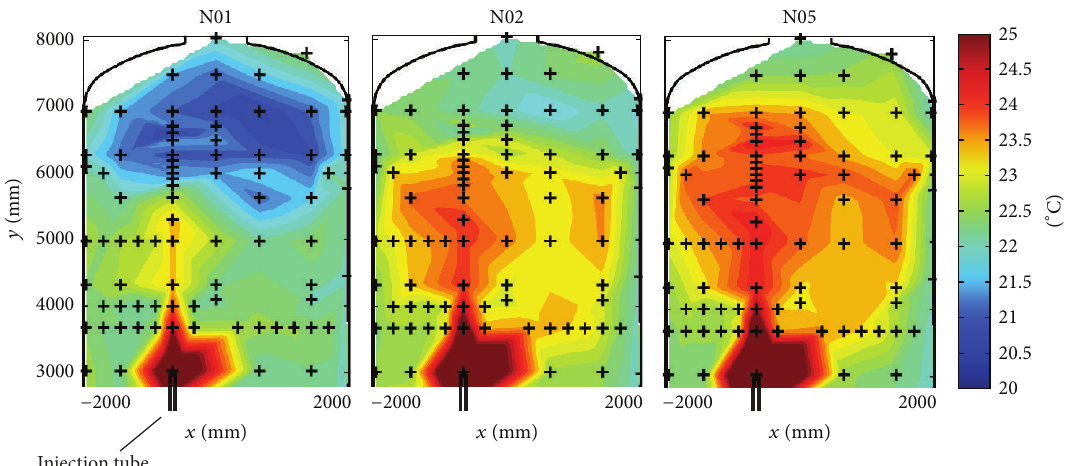
Injection tube Figure 13: Temperature contour maps for the entire vessel above the injection